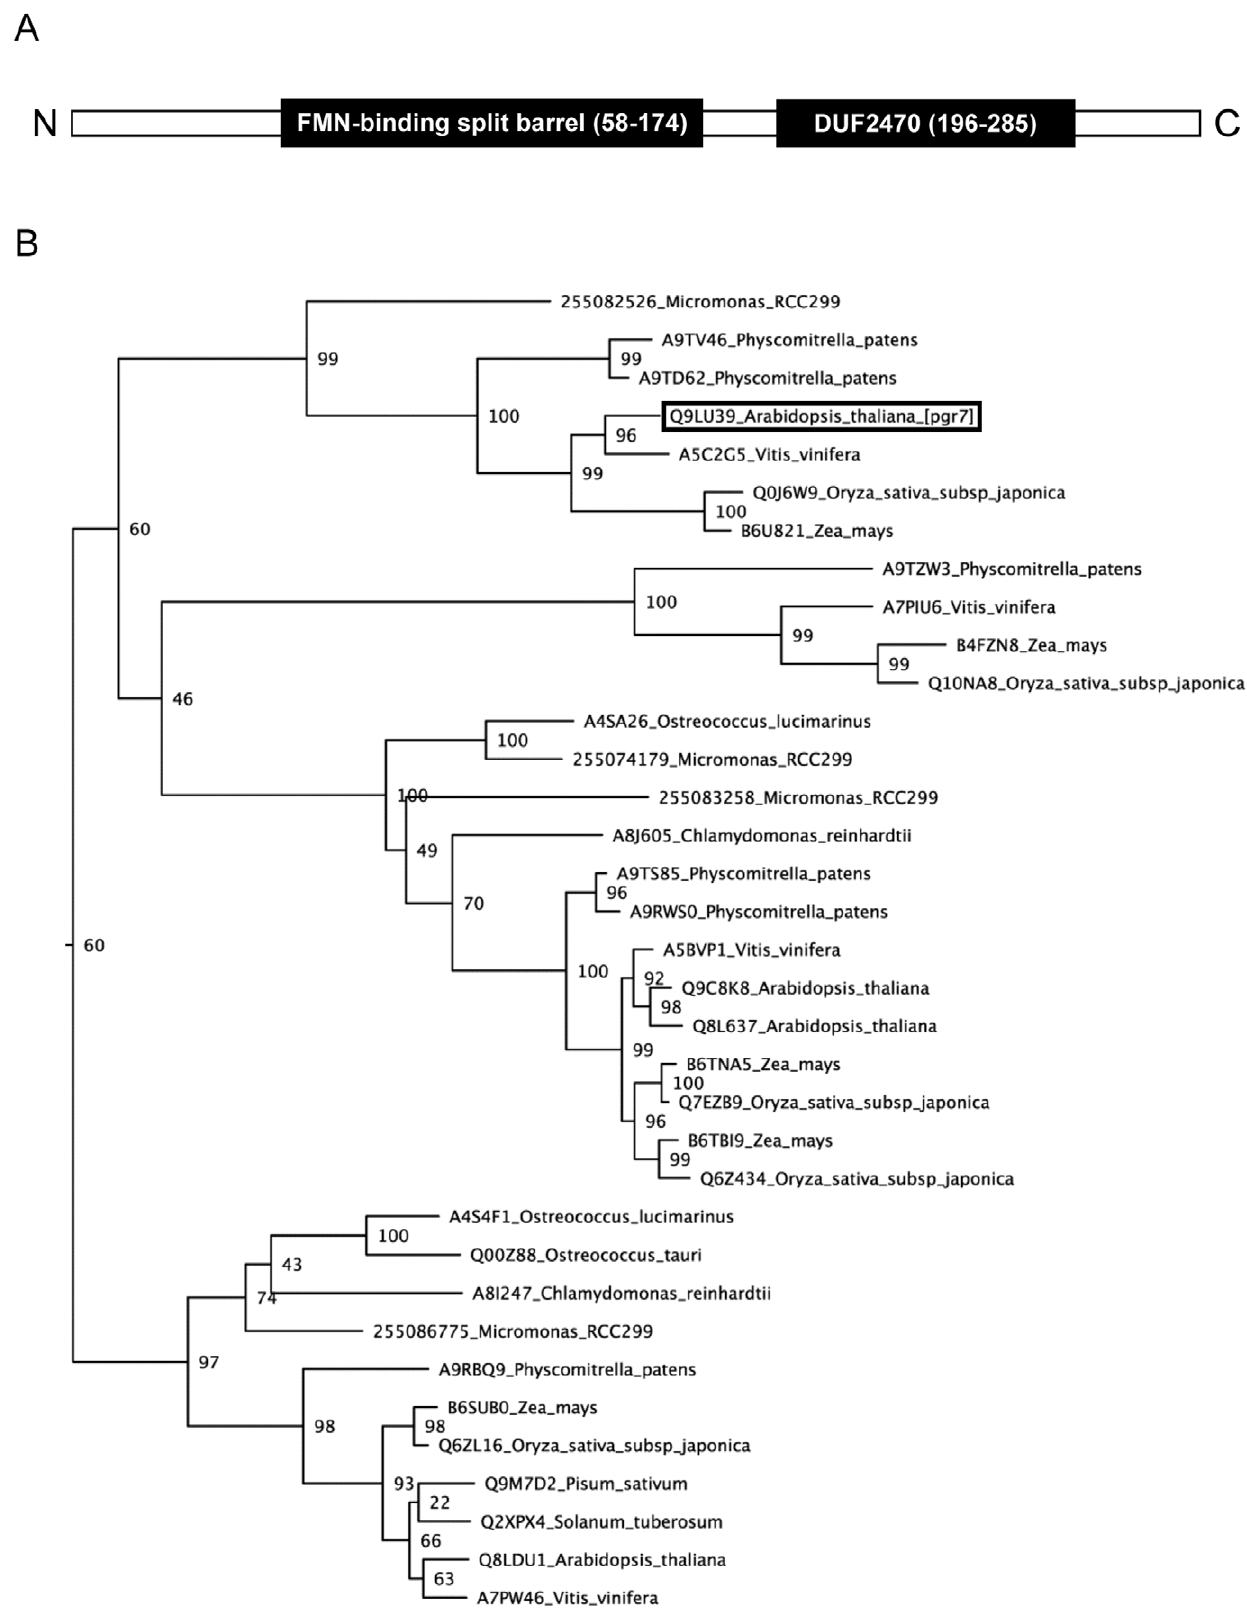
Figure 9. Identified domains and phylogenetic analysis of PGR7. A) Possible functional domains identified through Hidden Markov Model (HMM) construction and the positions of the FMN-binding split barrel domain and the DUF2470 domain in PGR7. B) Maximum likelihood